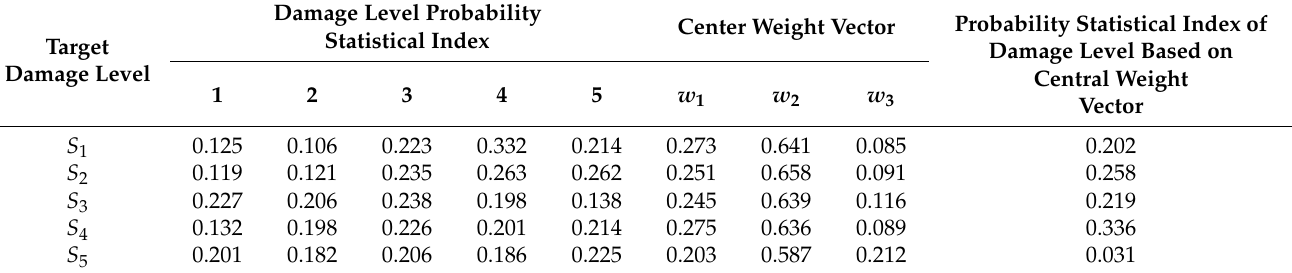
Table 2. The calculation results of target damage level when w 1 = 0.25, w 2 = 0.65, w 3 =